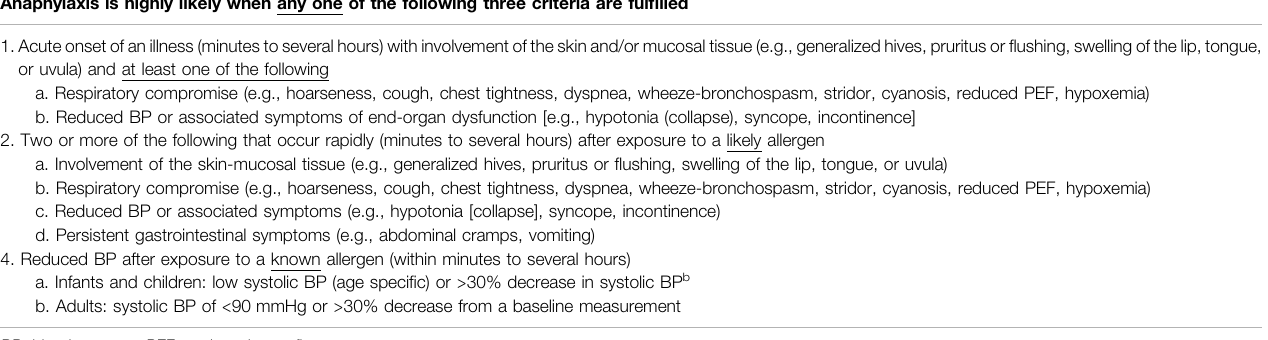
TABLE 3 | Clinical criteria for the diagnosis of anaphylaxis a